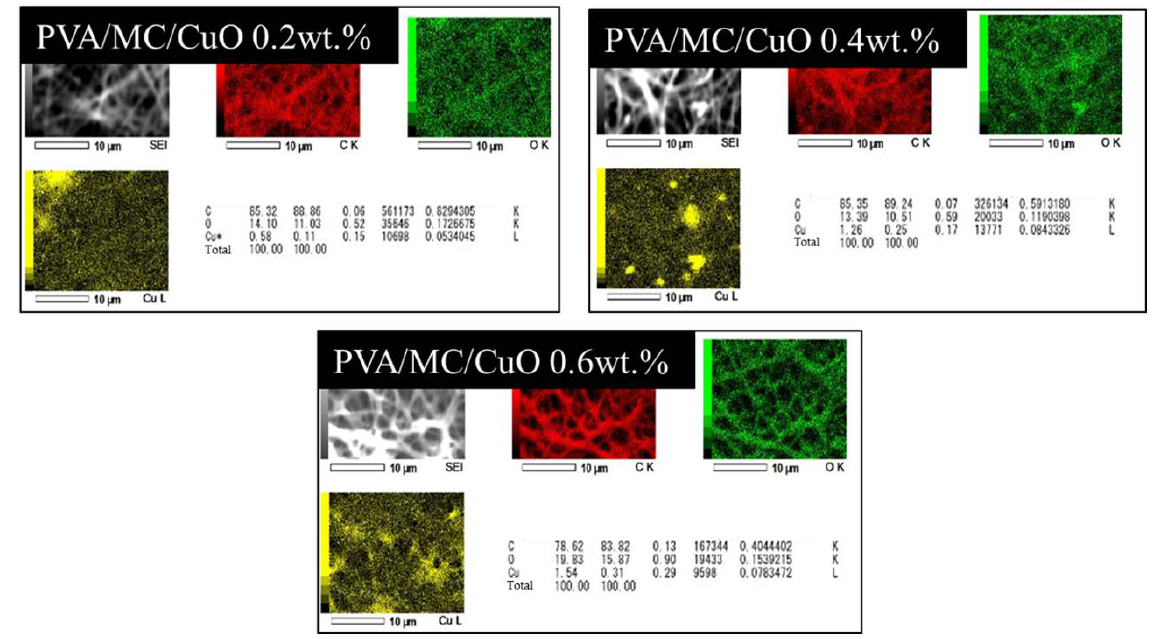
Figure 2. EDS analysis of PVA/MC/CuO 0.2 wt.%, PVA/MC/CuO 0.4 wt.%, and PVA/MC/CuO 0.6 wt.% nanofibers.